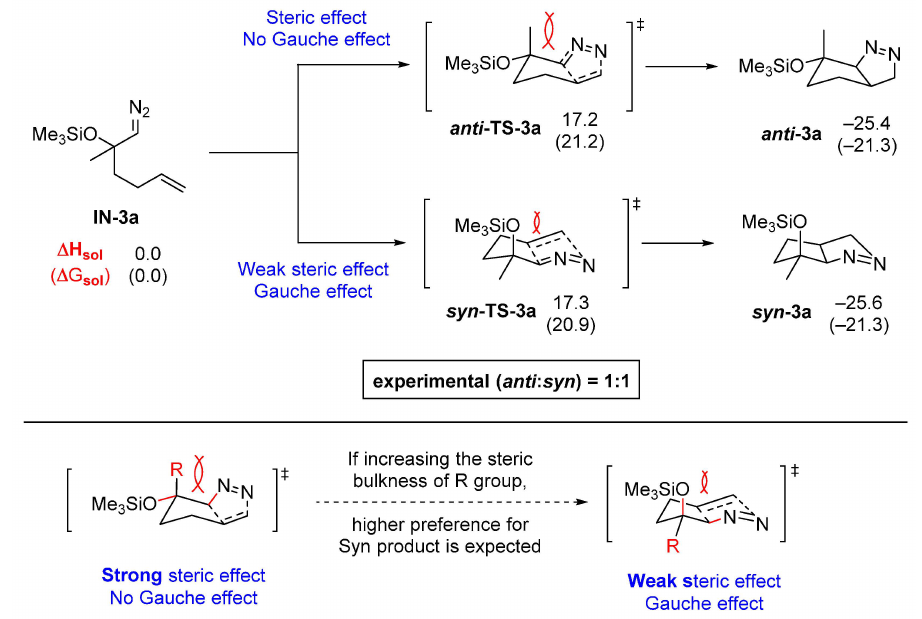
Figure 9. DFT calculations on pyrazolines formed with low diastereoselectivity (in kcal/mol).